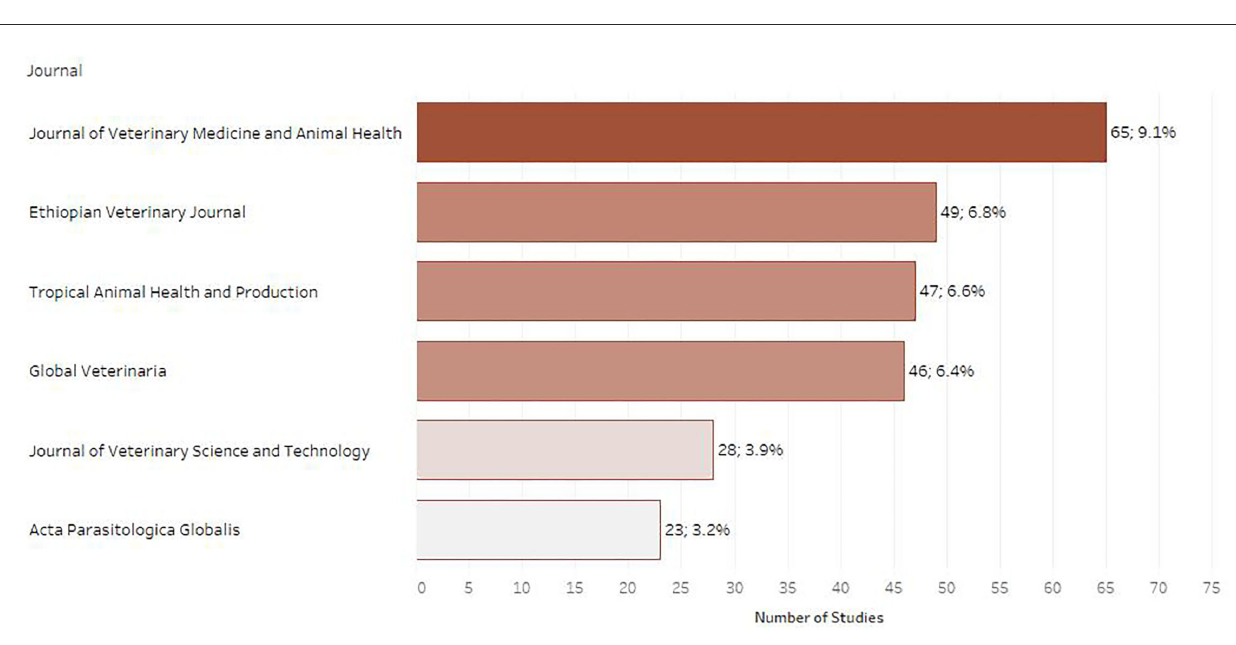
Bibliographical details and journal